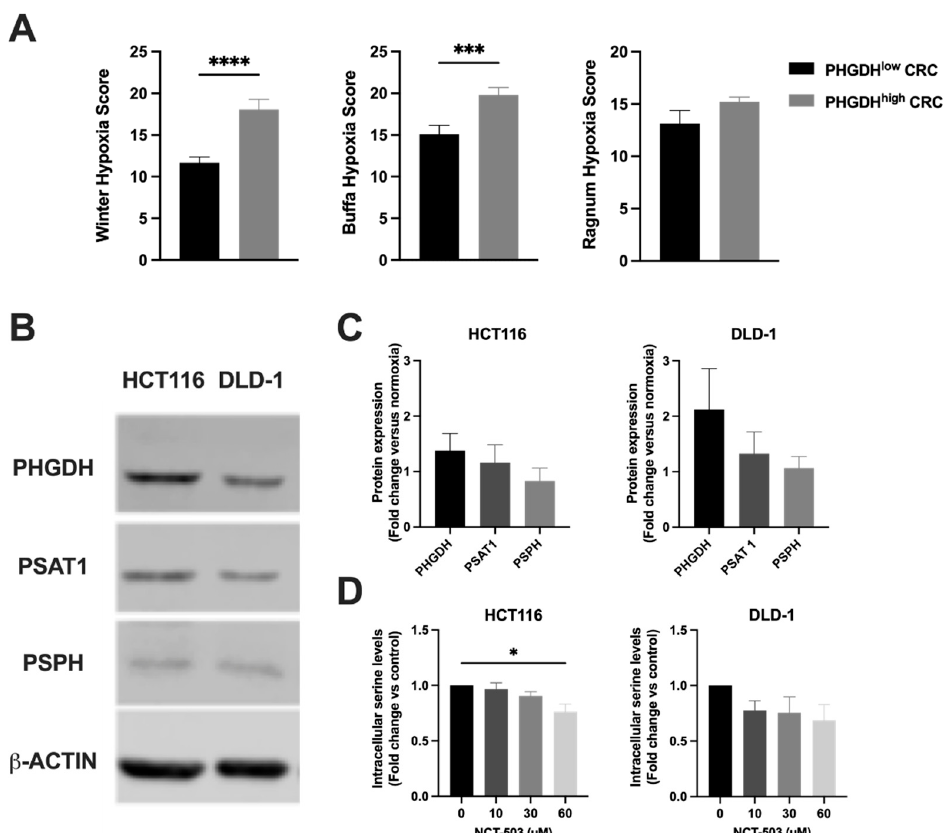
Figure 4. Hypoxia induces the expression of PHGDH in human colorectal cancers. ( A ) Correlation between PHGDH overexpression ( p ≥ 1.5) and hypoxia by assessing the Buffa, Winter and Ragnum hypoxia scores accessed through cBioPortal for Cancer Genomics. ( B ) Representative Western blots of PHGDH, PSAT1 and PSPH with β -actin as loading control in HCT116 and DLD-1 cells under hypoxic conditions (0.1% O 2 ). ( C ) Relative protein expression of PHGDH, PSAT1 and PSPH under hypoxic conditions (0.1% O 2 ) normalized to the expression under normoxic conditions. ( D ) D-serine levels were determined upon treatment with NCT-503 (5 h) at indicated concentrations under hypoxic conditions (0.1% O 2 ). Unpaired t-test ( A ) and ordinary one-way ANOVA with Dunnett’s multiple comparison test ( D ) were used to calculate statistics: * p < 0.05, *** p < 0.001, **** p < 0.0001. To assess this phenomenon in our culture system, we quantified the protein expres- sion levels of the SSP enzymes in human CRC cell lines HCT116 and DLD-1 in radiobio- logical-relevant hypoxic conditions (0.1% O 2 ) (Figure 4B). An upregulation of all three en- zymes could be observed compared to normoxic conditions (Figure 1C,D). The highest fold change between normoxic and hypoxic conditions could be observed for PHGDH in both cell lines, with a particular increase in DLD-1 cells (Figure 4C). The serine production upon treatment with NCT-503 was reassessed in hypoxic conditions (0.1% O 2 ) after 5 h of treatment. A similar loss of D-serine production was observed in both cell lines, with a tendency towards dose dependency (Figure 4D). Of note, the overall serine levels in hy- poxic conditions convey the impression of being elevated compared to normoxic condi- tions.